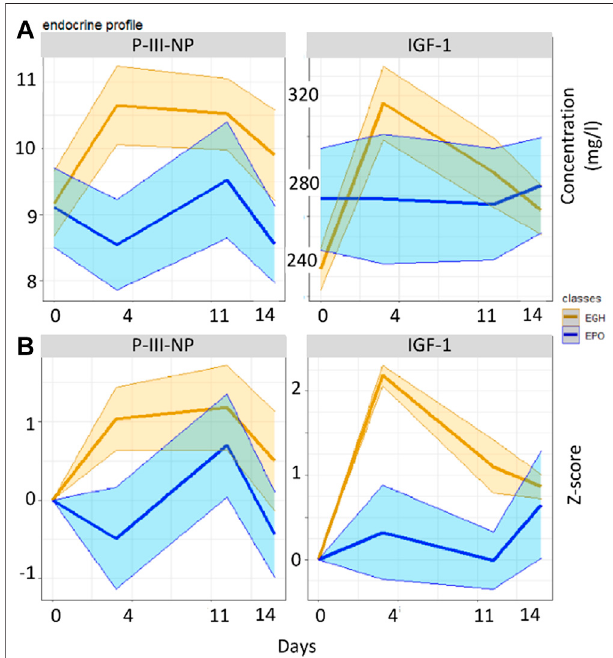
FIGURE 2 | Boxplots reporting the values of the two groups across the various time-points in the original data (A) and in the GTA-transformed data (B)